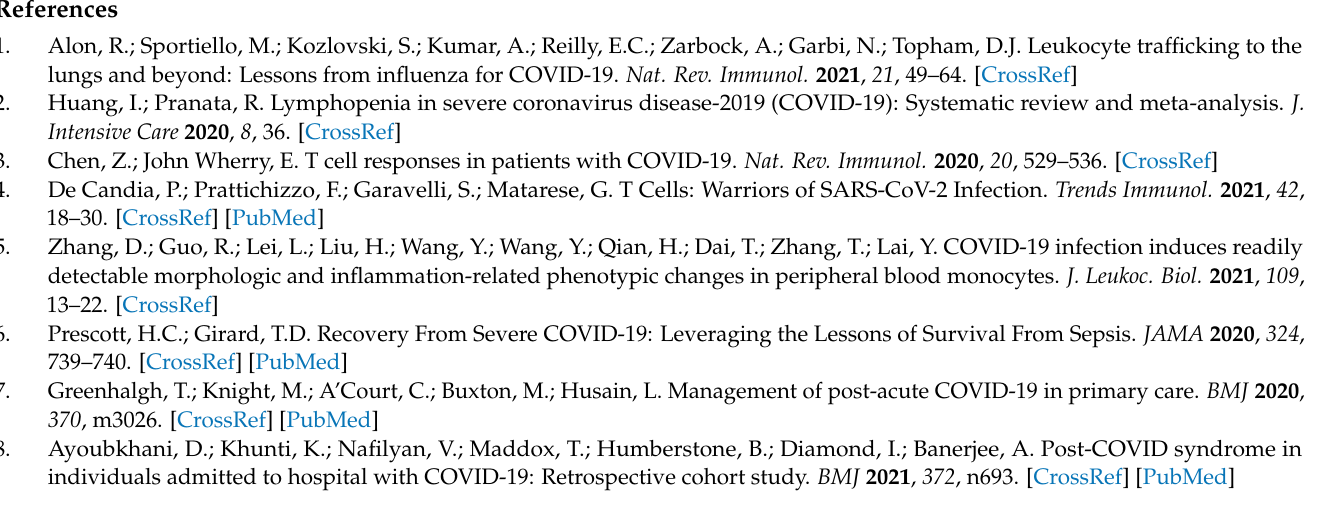
Supplementary Materials: The following are available online at https://www.mdpi.com/article/ 10.3390/v13112239/s1, Figure S1: Gating strategies for flow cytometry data analysis, Figure S2: Expression of activation markers on unstimulated T cells, Table S1: Criteria and identification of individuals with SARS-CoV-2 and other respiratory infections, Table S2: Fluorophore-conjugated antibodies used for flow cytometry, Table S3: Summary of SARS-CoV-2 PepTivator AIM assay T-cell activation observations, Table S4: All immune parameter data analysis, Table S5: Monocyte surface receptor expression as mean fluorescence intensity